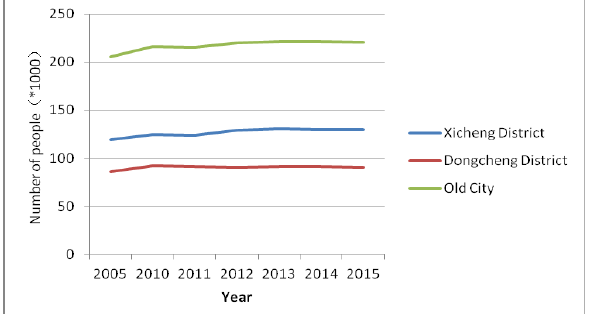
Figure 3. Change of population in Old city over years from 2005 to 2015